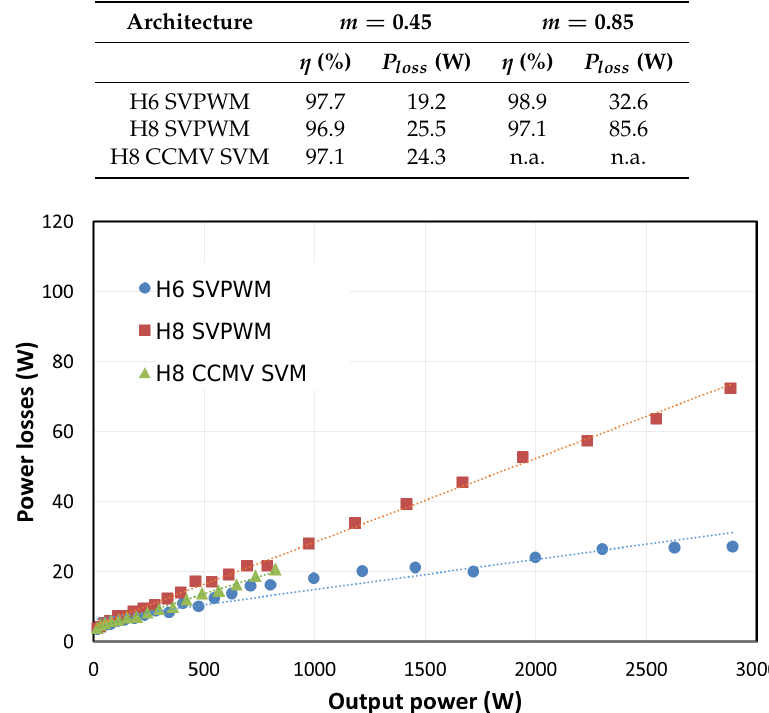
Figure 14. Power losses of SiC power MOSFETs versus output power